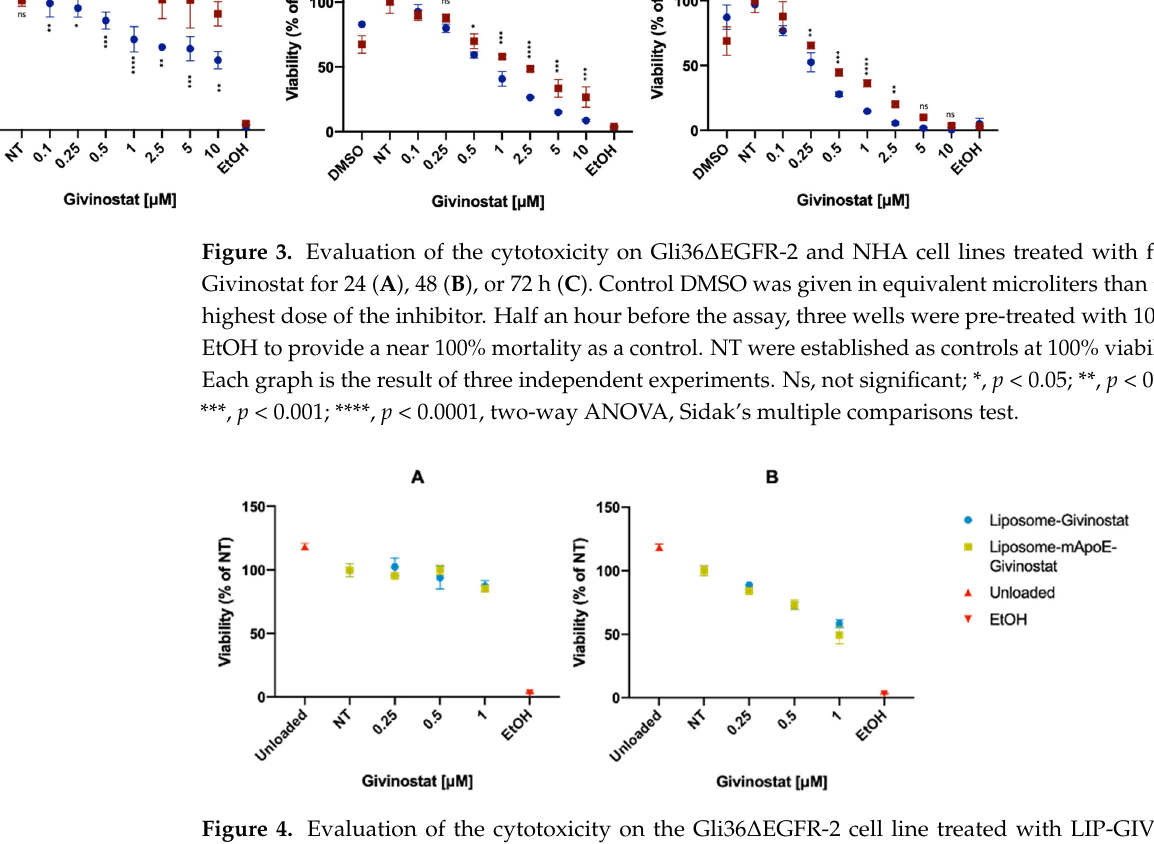
LIP/m ‐ GIV for 24 ( A ) or 48 h ( B ). The “unloaded” sample represents the unfunctionalized liposome